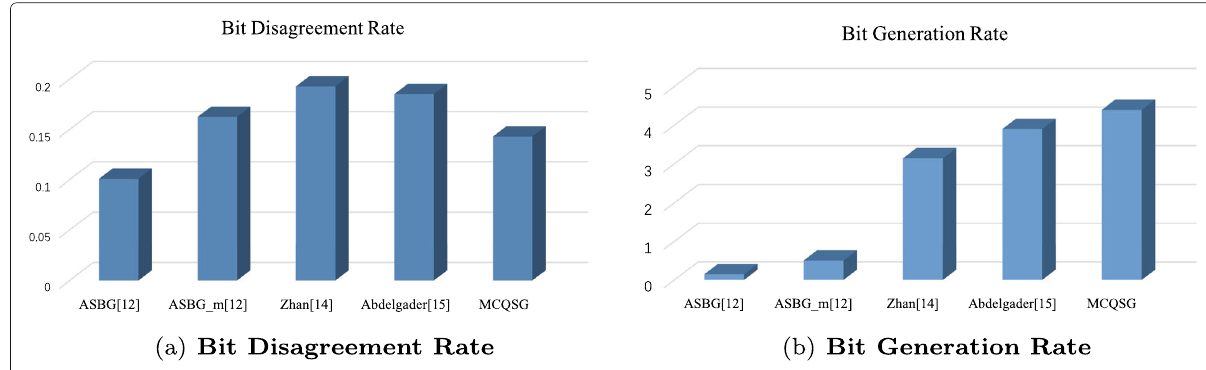
Fig. 15 BGR and BDR comparison of various